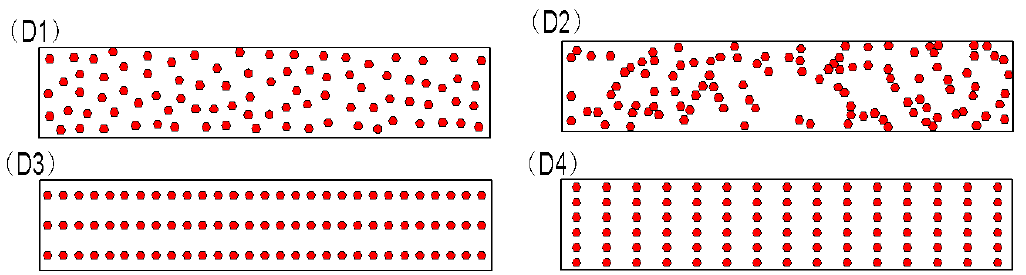
Figure 10. Diamond distributions D1–D4. See text for details.